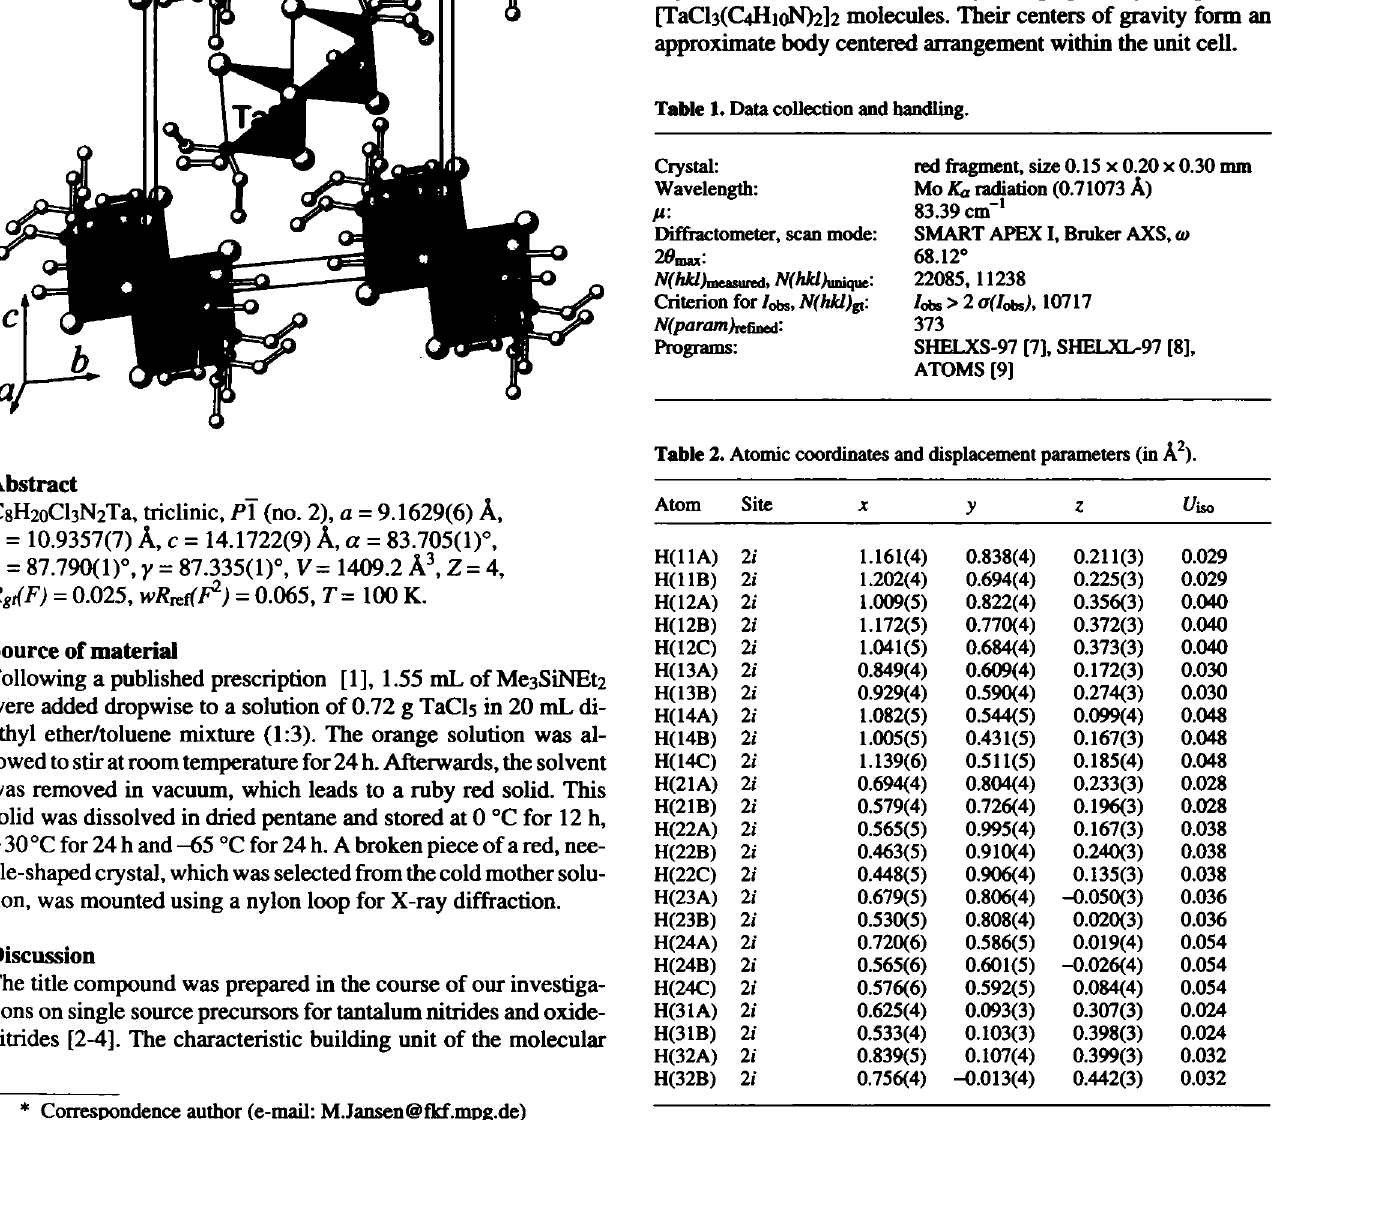
Table 2. Atomic coordinates and displacement parameters (in Â 2